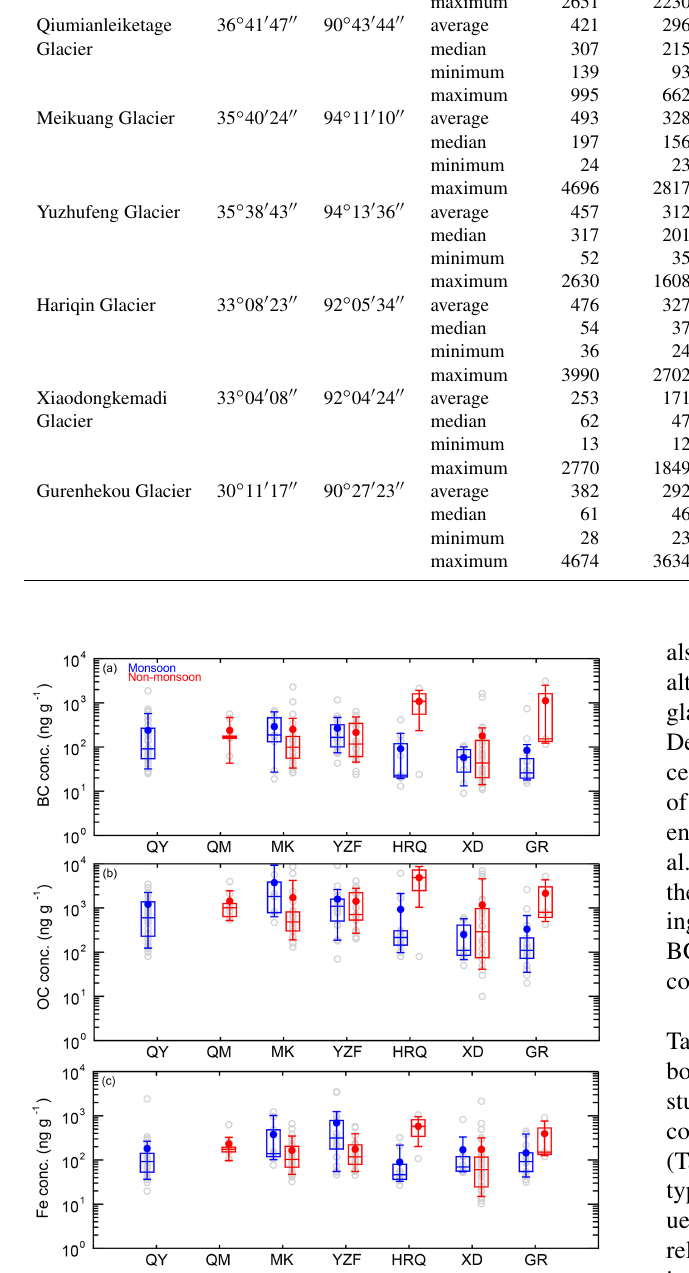
Figure 6. Box plots depicting the regional variability in (a) BC con- centration, (b) ISOC concentration, and (c) Fe concentration on the seven glaciers. The solid dots represent the average ILAP concen- trations for each glacier, and the bars represent the 10th, 25th, me- dian, 75th, and 90th percentiles of the